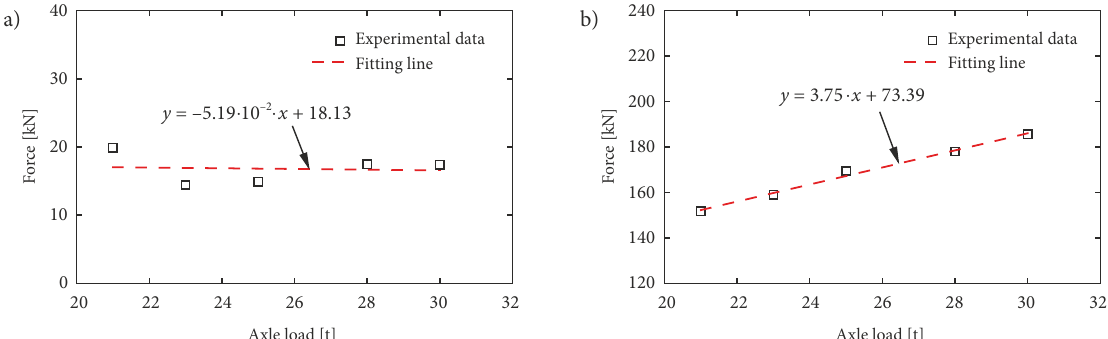
Figure 12. Variations of the peak values of the wheel–rail force with axle load: a – lateral; b –